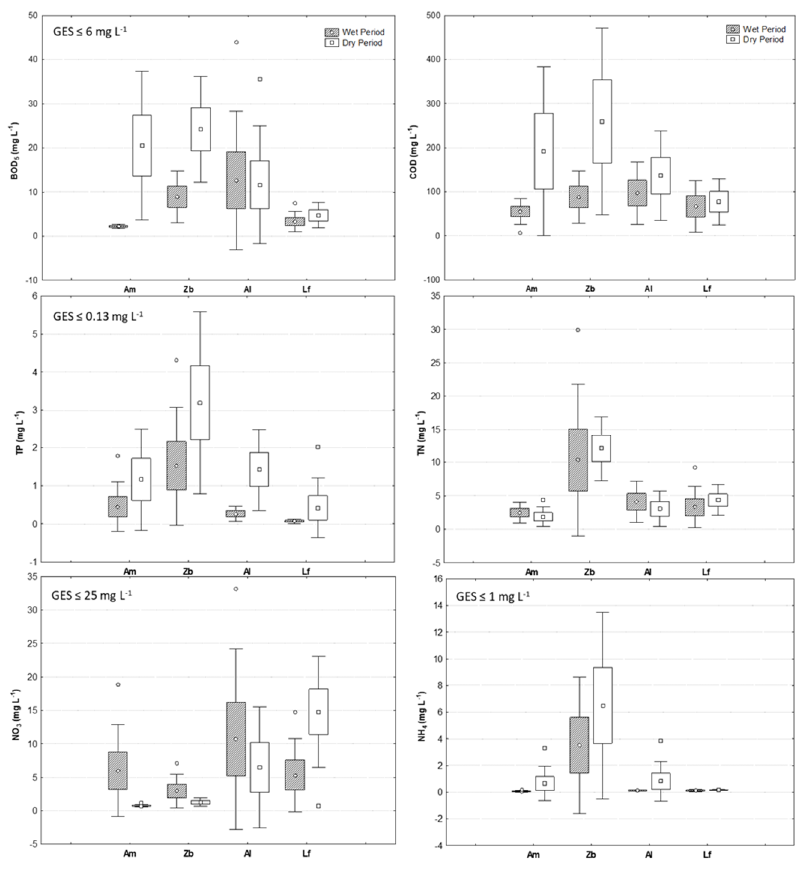
Figure 4. Spatial and temporal variation of the organic descriptors and nutrients in the water samples during the period of the study. The mark across the box represents the mean, and the bottom and top of the box show the standard deviation. Whenever possible, recommended guide levels for the good ecological status (GES) were represented [47].